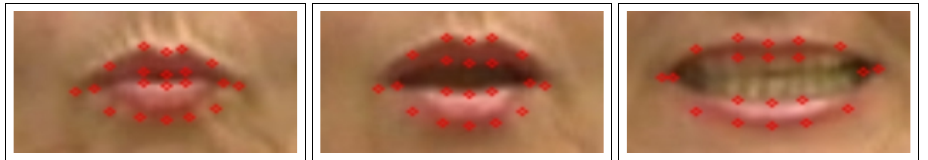
Figure 5. Illustration of the proposed mouth states: closed ( left ), open without detectable teeth ( center ) and open with detectable teeth ( right ). Image originates from VidTIMIT [42] dataset with application of keypoint generation by dlib [36] and